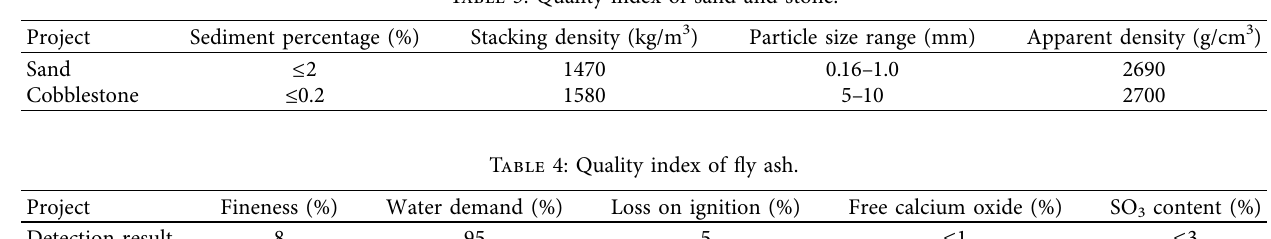
Table 3: Quality index of sand and stone.